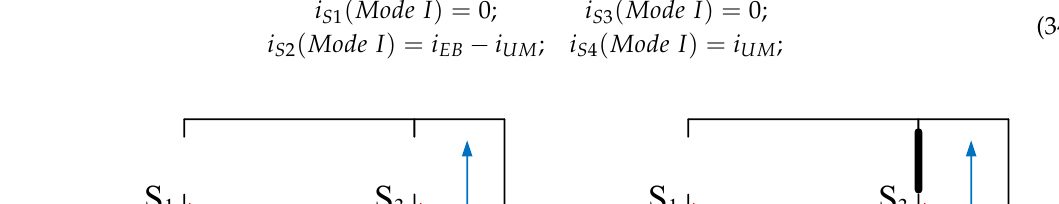
(only in transients). D